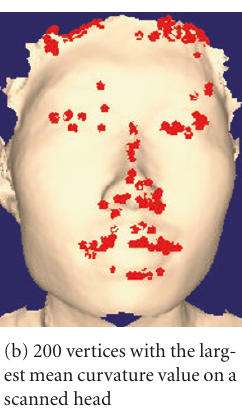
Figure 5: Curvature-based point